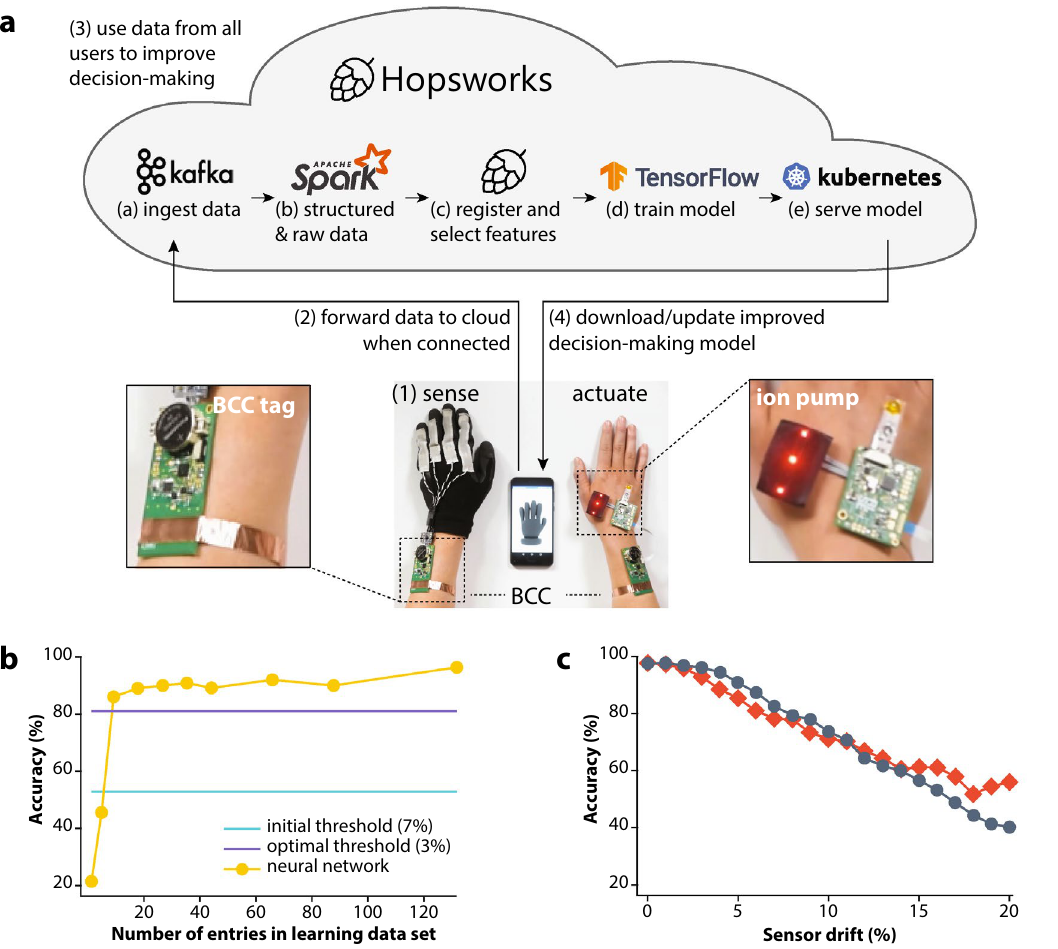
Figure 3. Digital nervous system integration and implementation of machine learning. ( a ) The DNS proof-of- concept, where the sensing node (glove) state was received by the base unit/tag (in contact with person, but out- of-view during filming) and forwarded to the actuator node (ion pump) through the capacitive field of the body. The received state was further sent from the base unit to the mobile device via Bluetooth for interaction with the Hopsworks cloud-based machine learning system (steps 1–4 and a – e ). ( b ) Accuracy of a neural network classification of the hand position as a function of the quantity of data used to train it, compared to the accuracy of an initial estimated threshold and an optimized threshold corresponding to bent fingers. ( c ) Accuracy of a neural network classification of the hand position as a function of the simulated drift in sensor measurements compared to the training data. The drift was applied on one finger (grey) or all fingers (orange) at the same magnitude. Photographs in part a taken by Thor Balkhed at Linköping University, and used with